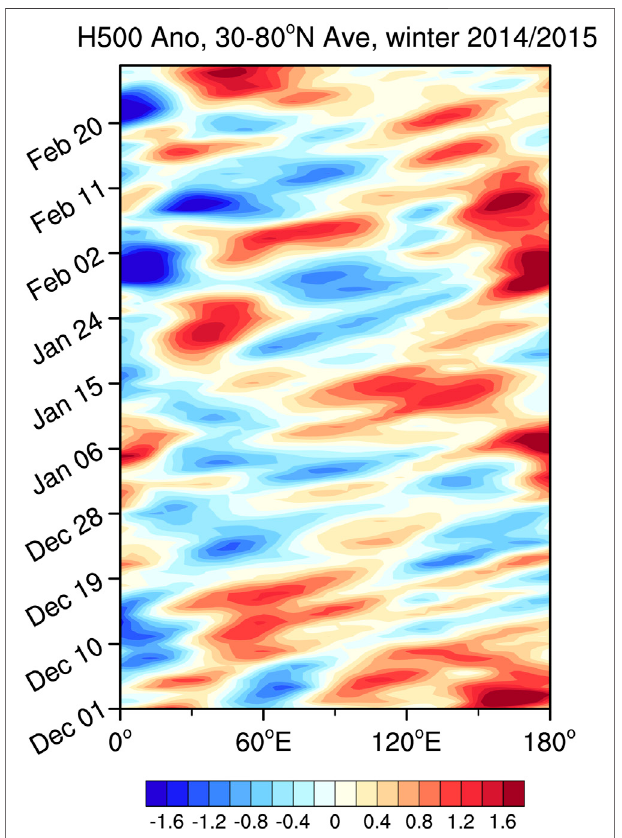
FIGURE 3 | Time – longitude cross-section of 500 hPa geopotential height (unit: 100 m) averaged between 30 ° N and 80 ° N in winter 2014/2015.